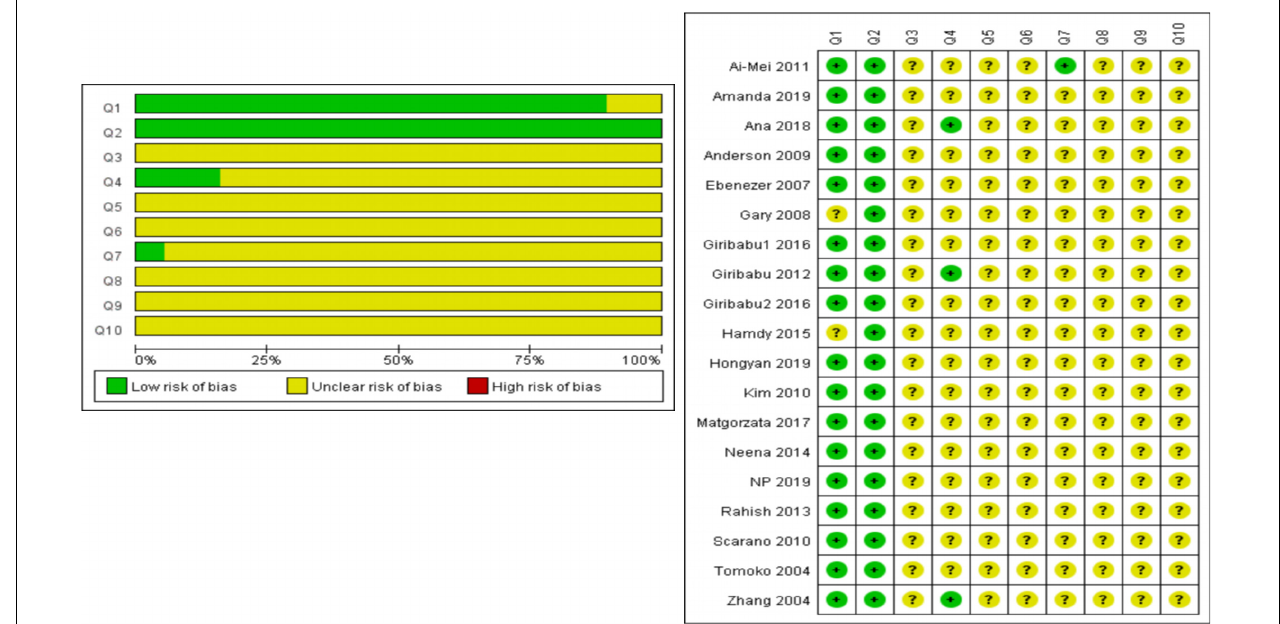
FIGURE 2 | The preliminary analysis results of RoB’s assessment and methodological quality indicators.